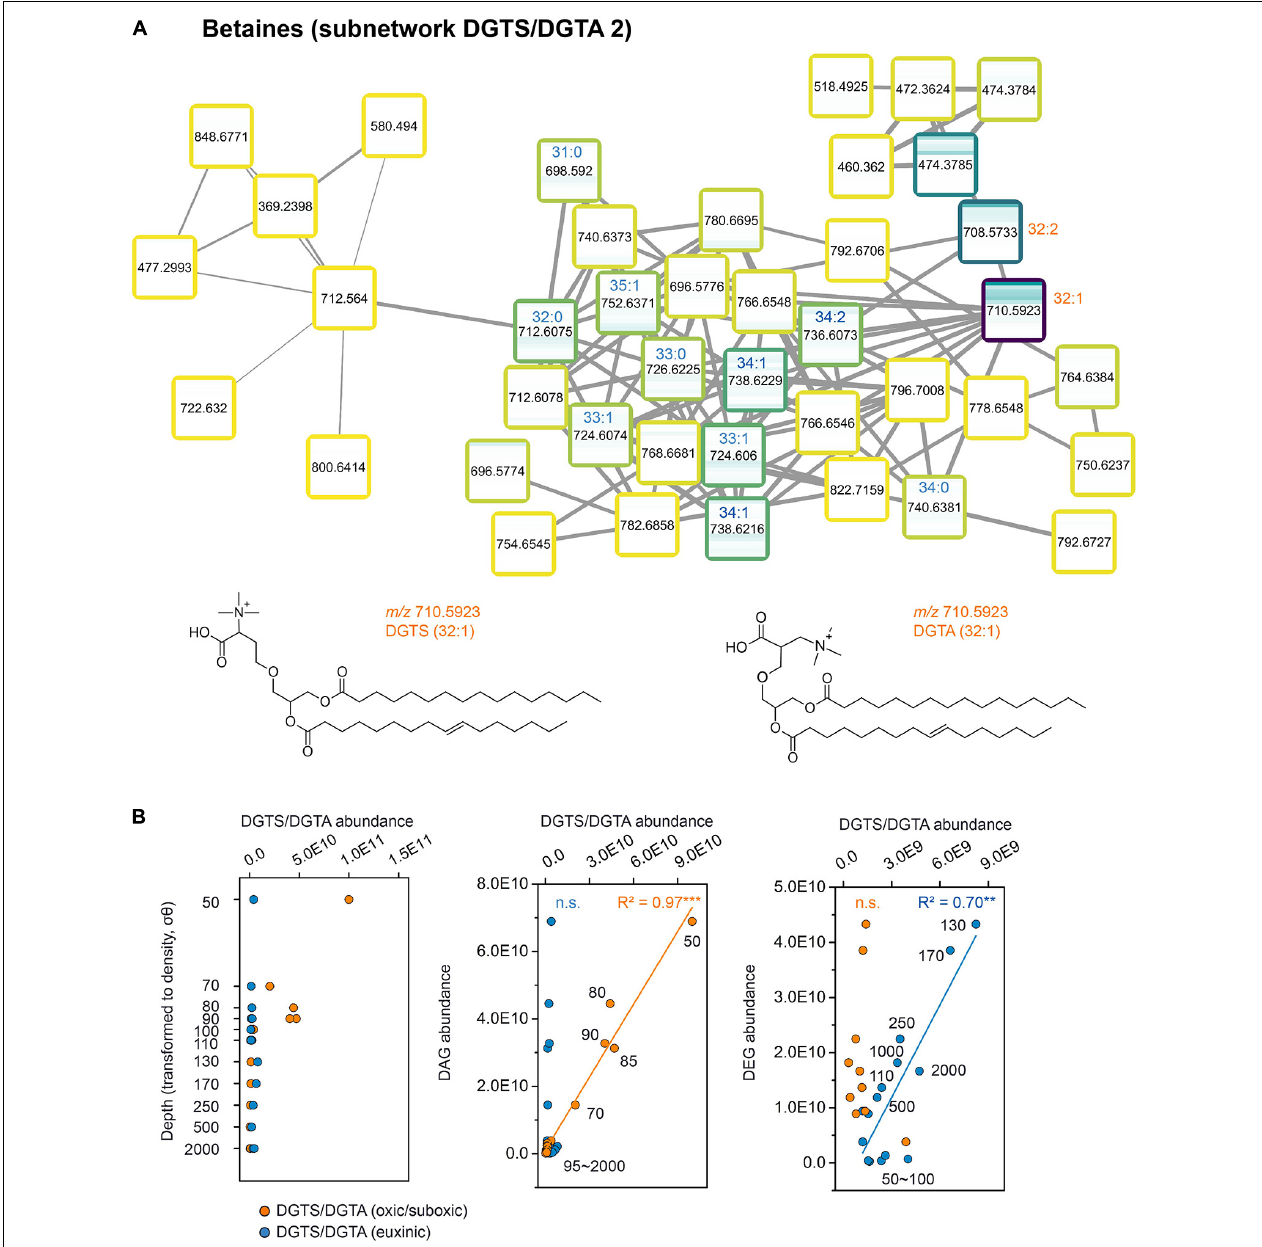
FIGURE 5 | Molecular subnetwork of betaine lipids (DGTS/DGTA) and their source determination. (A) Subnetwork of betaine lipids DGTS/DGTA. (B) From left to right: Distribution of DGTS/DGTA (oxic to suboxic, abundant at the surface water 50–90 mbsl, including DGTS/DGTA with C 32 : 2 , C 32 : 1 , C 34 to C 40 carbon chain length and 0–10 double bonds, orange cycles) and DGTS/DGTA(euxinic, abundant at the deep water 110–2,000 mbsl, including DGTS/DGTA with C 31 to C 35 carbon chain length and 0–2 double bonds, blue cycles); Scatter plots of DAG vs. DGTS/DGTA (oxic/suboxic, orange cycles) and DGTS/DGTA (euxinic, blue cycles); Scatter plots of DEG with several head groups (PE/PG/PI) vs. DGTS/DGTA (oxic/suboxic, orange cycles) and DGTS/DGTA (euxinic, blue cycles). Significance: *** P < 0.001; ** P < 0.01; n.s., not significant. The name of selected DGTS/DGTA is linked to the one in the major network ( Figure 2 ). Boxes shown in subnetwork are the same as nodes shown in Figure 2 , representing lipid species. The outlines of the boxes are labeled from light yellow to dark blue with the increasing of the summed intensity among all the water column samples (15 depths). Inside the box, a heatmap represents the distribution of this lipid species across the water column, from top (50 mbsl) to bottom (2,000